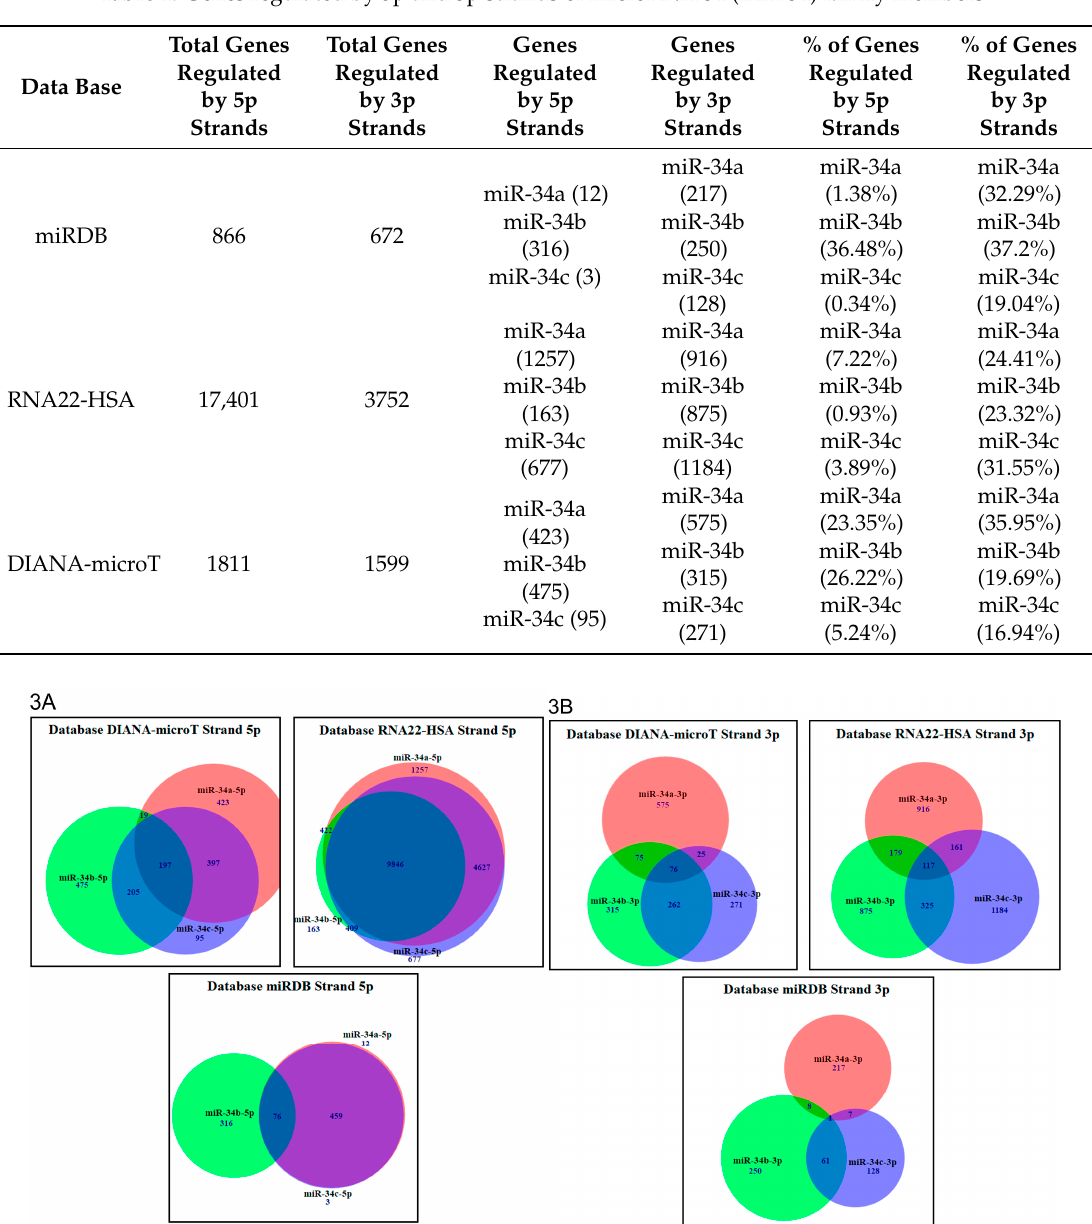
Table 1. Genes regulated by 5p and 3p strands of microRNA 34 (miR-34) family members.